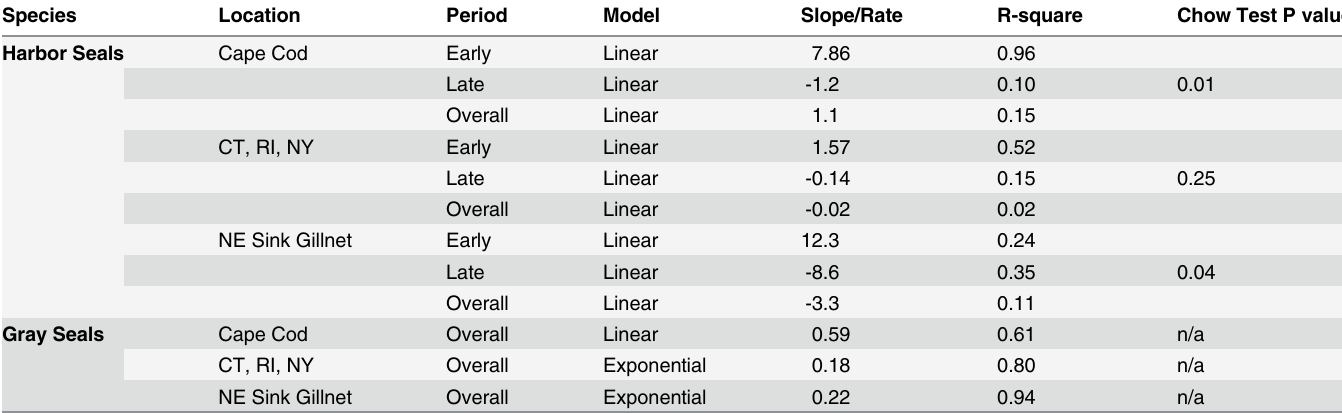
Table 1. Details on linear and exponential models fit to strandings of harbor and gray seals in the Cape Cod and Connecticut, Rhode Island, and Fisher ’ s Island, New York regions, and bycatch for the Northeast Sink Gillnet Fishery.